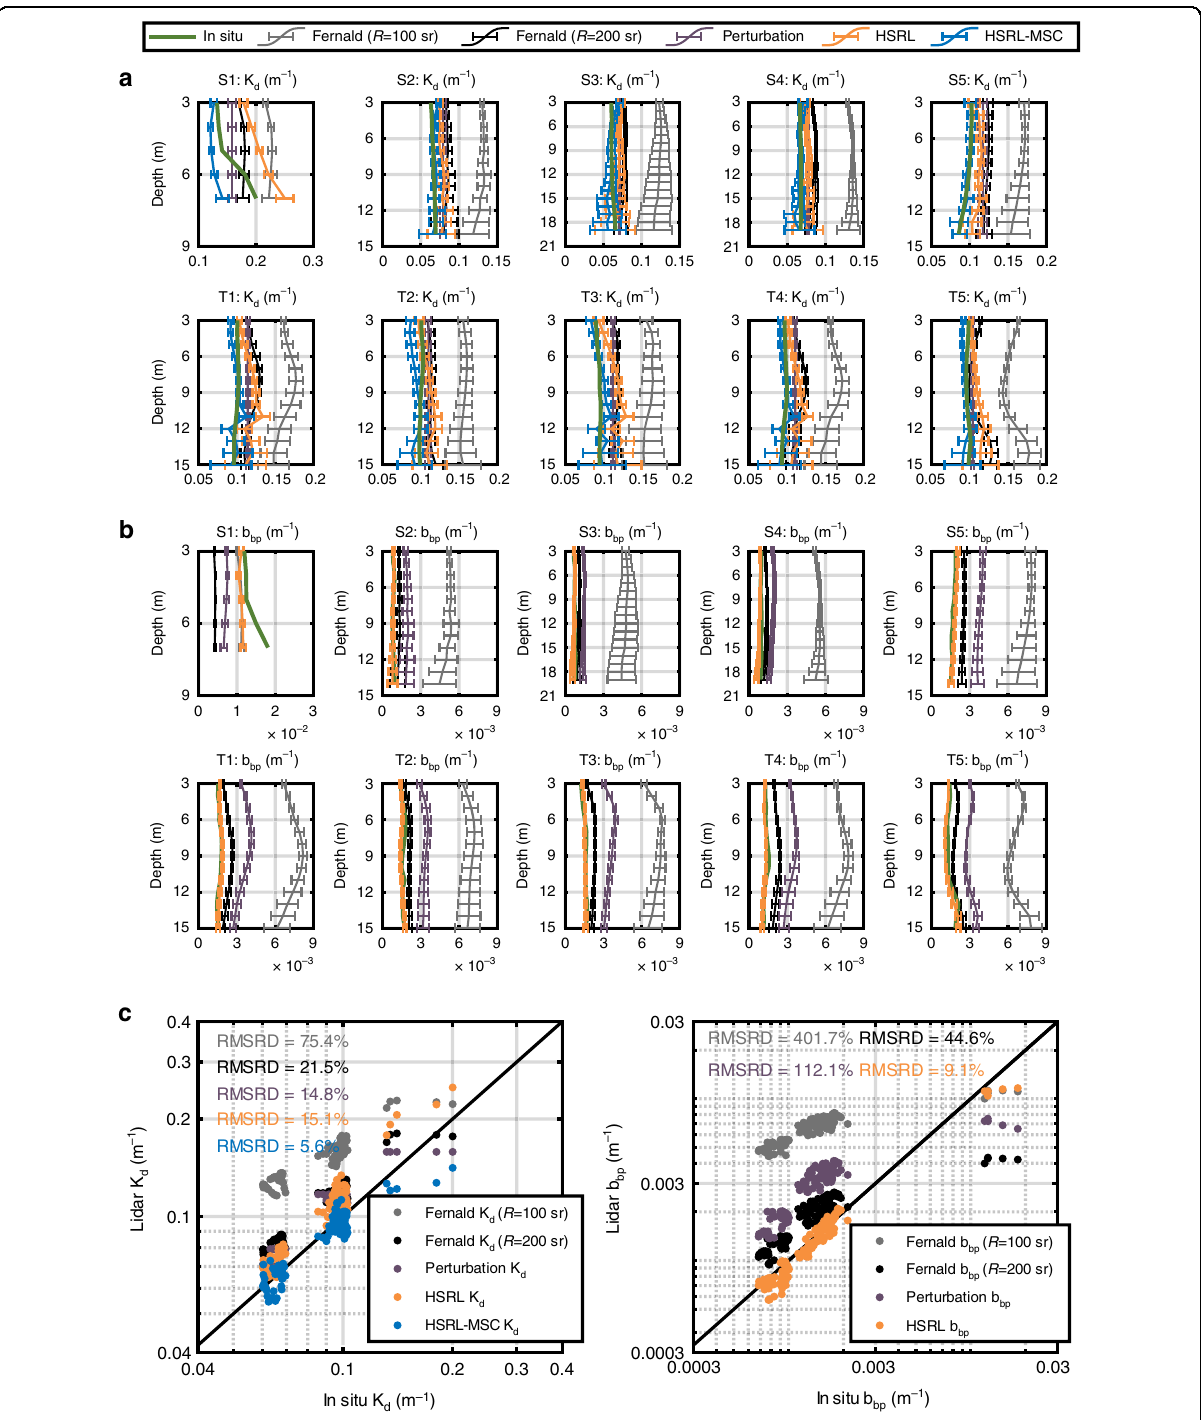
Fig. 5 The consistency check of HSRL retrievals. a Comparisons of K d . b Comparisons of b bp . The orange represents outputs of HSRL retrieval algorithm and blue refers to K d of HSRL retrieval and MSC algorithm in Fig. 2. Fernald method based on lidar ratios of 100 sr (gray) and 200 sr (black) and perturbation method (purple) are used for the elastic backscatter lidar. All lidar results are validated by in situ measurements (green) in c statistical analysis of K d and b